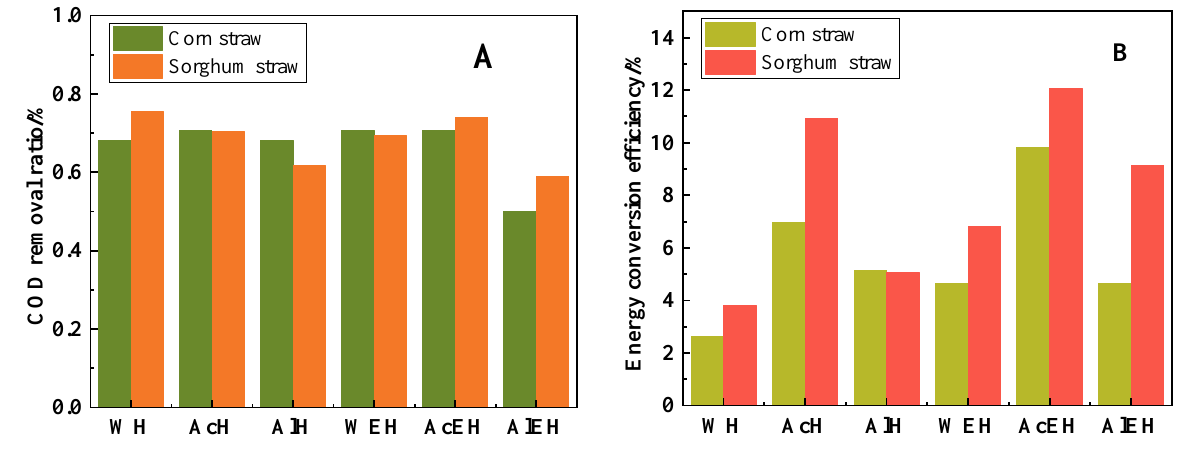
Figure 6. The COD removal ratio ( A ) and energy conversion efficiency ( B ) of photo-fermentation of straw hydrolysate.